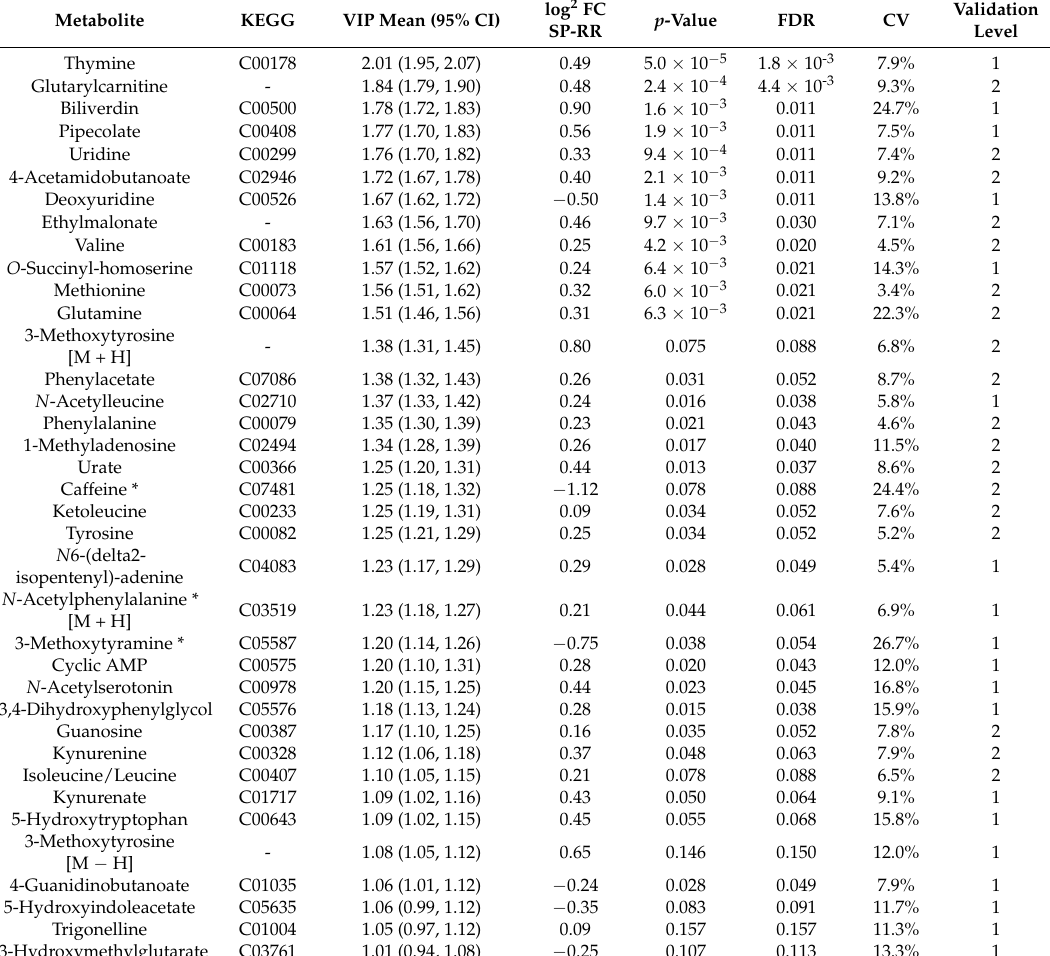
Table 2. Altered metabolites with an average VIP score greater than or equal to 1.0 from the PLS-DA comparing SPMS with RRMS patients. A positive log 2 fold change (FC) SP-RR indicates an averaged increase in SPMS compared with RRMS patients and vice versa. Identities confirmed by m / z and elution time of the internal standards and by MS/MS fragmentation pattern (validation level 2). Identities confirmed by m / z and elution time of the internal standards (validation level 1). Coefficient of variation (CV) is reported for all altered metabolites in the QC